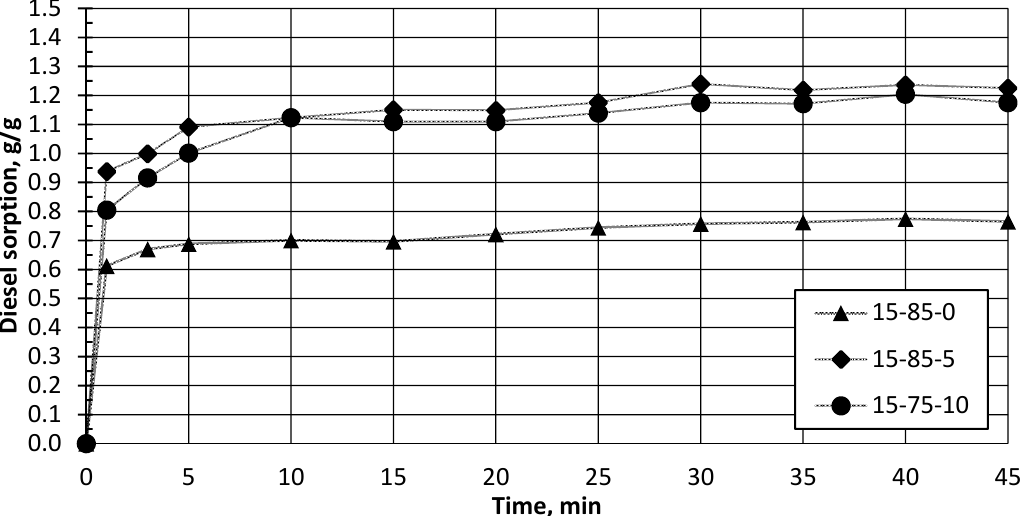
Figure 11. Diesel adsorption, in g/g for granules compositions series with 0 wt.% (15–85–0), 5 wt.% (15–85–5), and 10 wt.% (15–75–10) of CS.